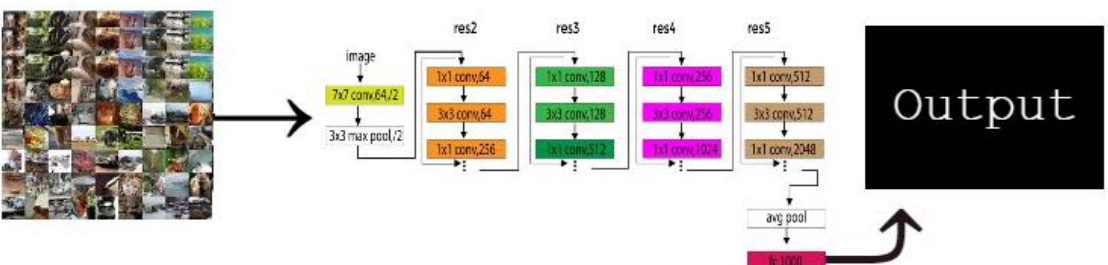
Figure 3. Original ResNet101 pre-trained CNN model for image classification.